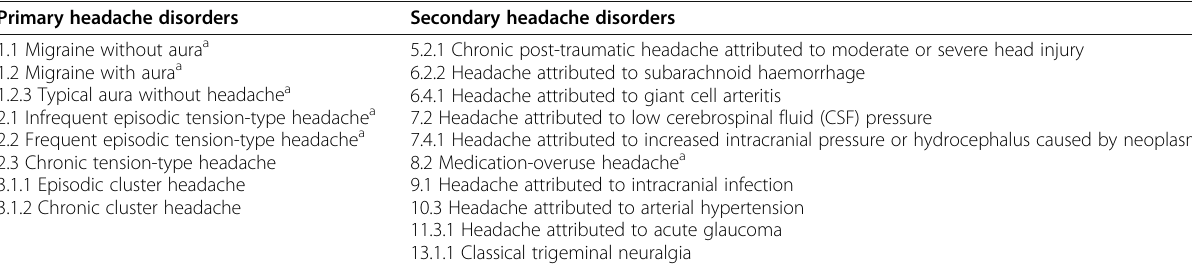
Table 4 ICHD-3 diagnoses [81] to be recognized at level 1 (from [29], updated from [28]) Primary headache disorders